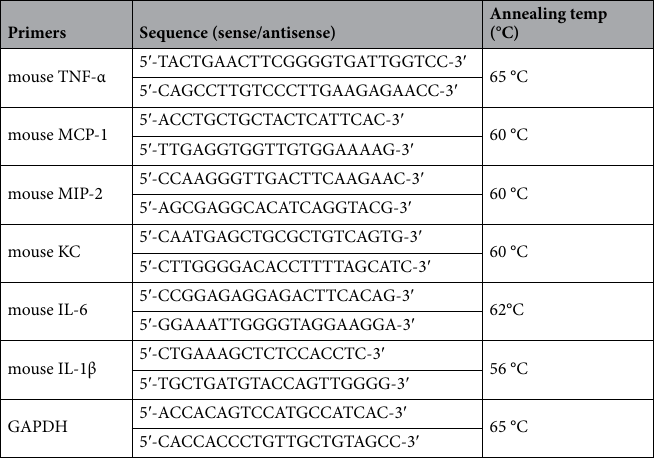
Table 1. Primers used in quantitative reverse transcription polymerase chain reactions to amplify mouse cDNAs based on published GenBank sequences. Annealing temperatures used for each primer are also